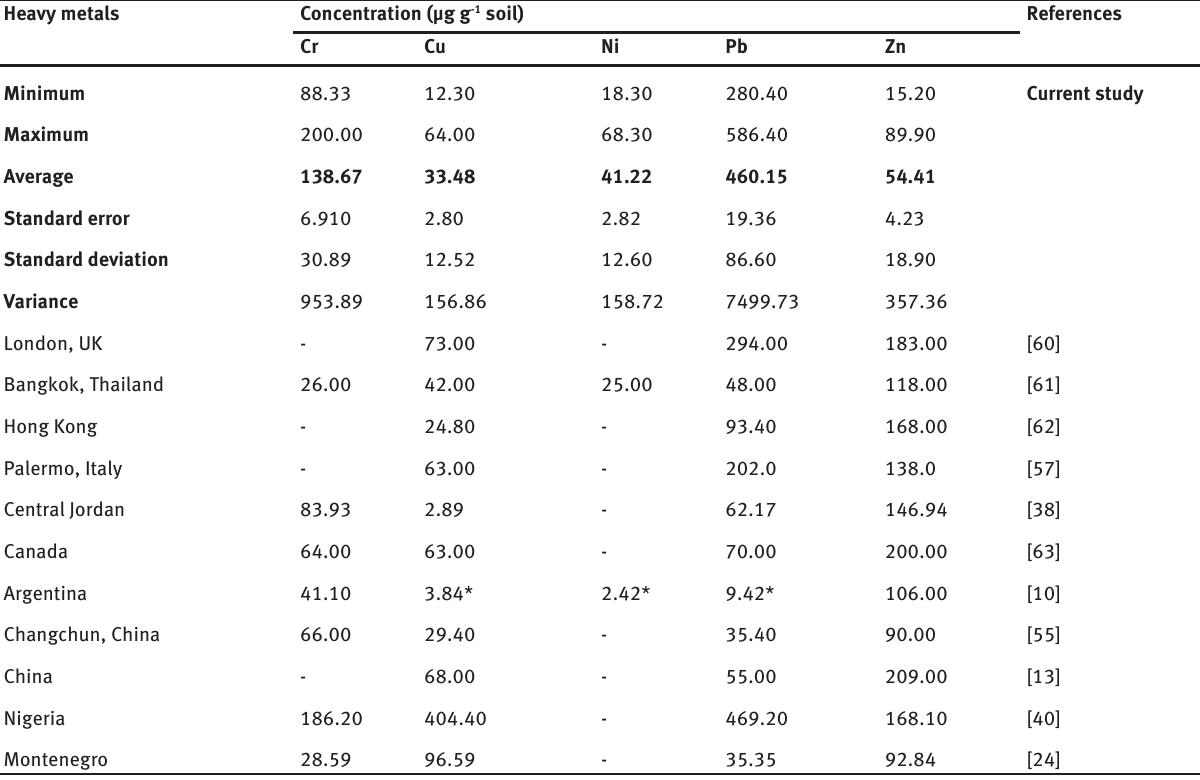
Table 3: Range of variation and descriptive statistics for the heavy metal concentrations in the soil comparing with the other countries. Heavy metals